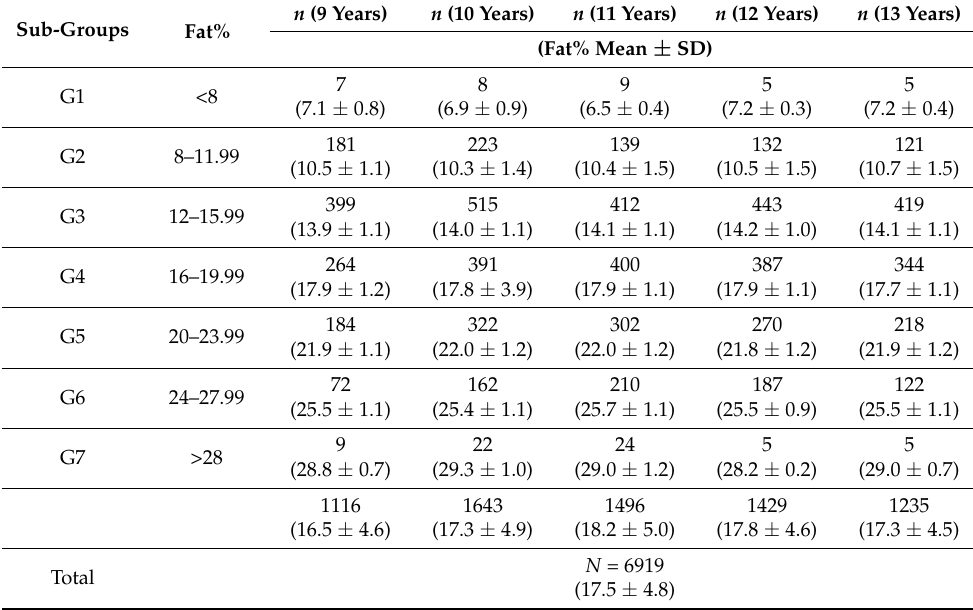
Table 1. Body fat percentage categories (mean ± SD) and number of boys in the five age groups.